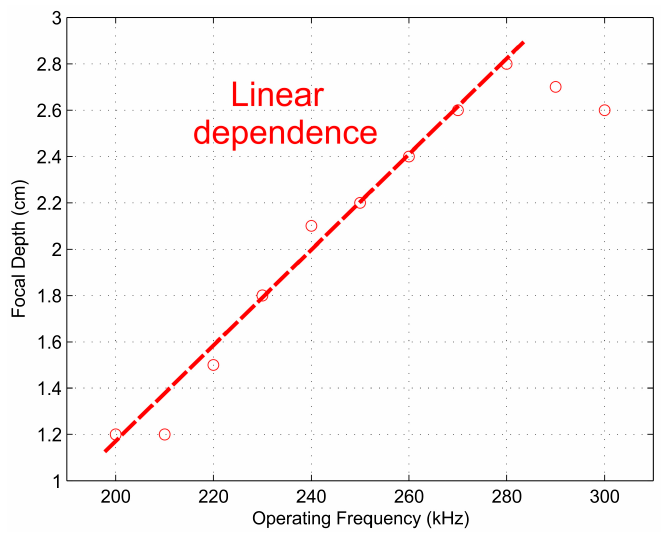
Figure 11. Measured focal depth against operating frequency.